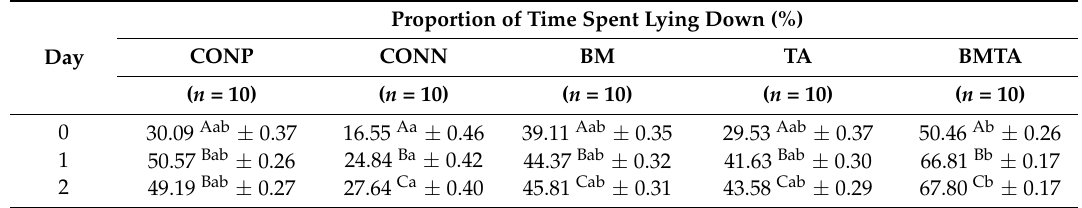
Table 3. Proportion of time spent lying by calves in each treatment group on days 0, 1 and 2.